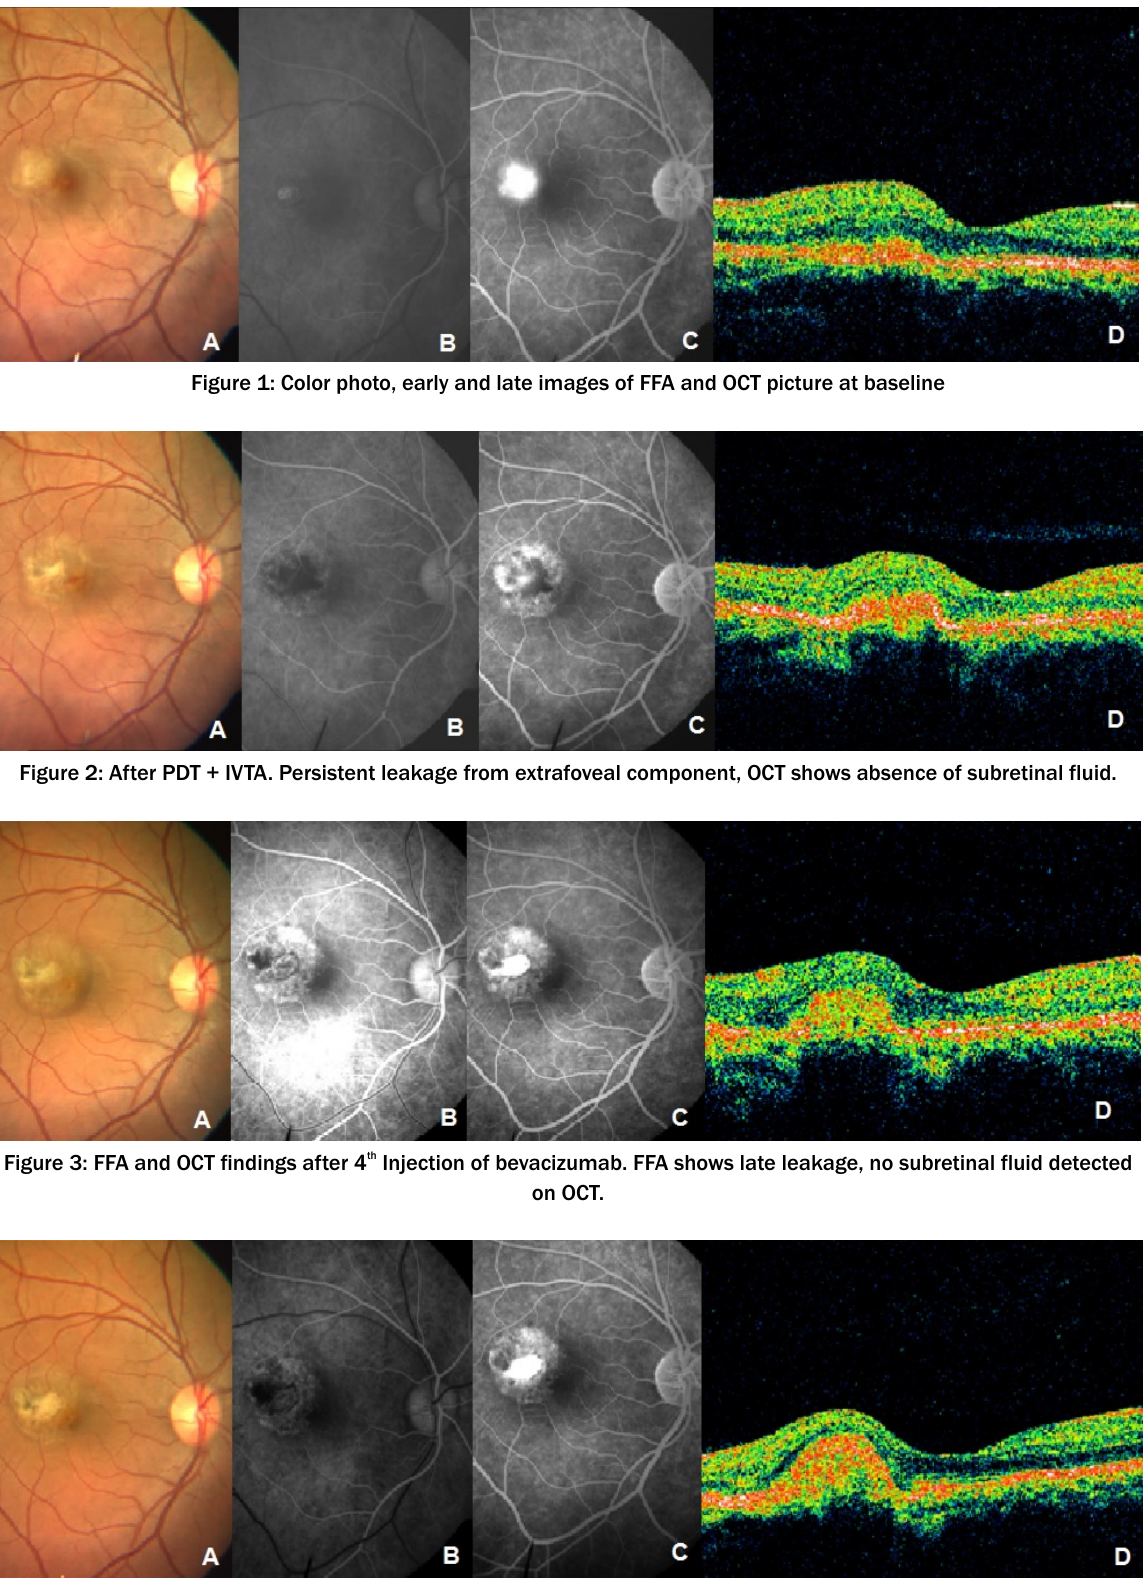
Figure 4: Findings on FFA and OCT at last visit. Staining of the scar is seen on FFA, no subretinal fluid visible on